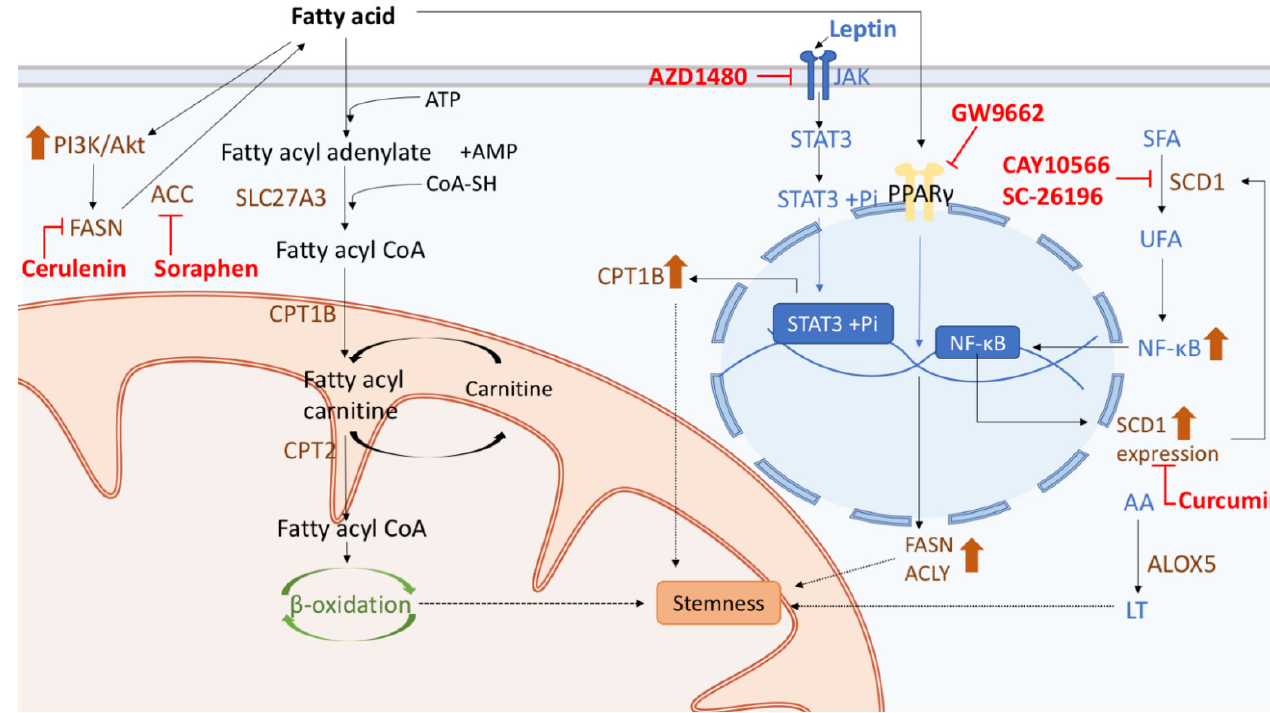
Figure 4. The regulation of fatty acid metabolism in CSCs. Lipid metabolism plays an important role in regulating the stemness properties of CSCs. In the pathway of fatty acid metabolism, acyl-CoA synthetase very-long-chain 3 (ACSVL3/SLC27A3) promotes the conversion of fatty acyl adenylate to fatty acyl CoA, which subsequently leads to β -oxidation of fatty acids and confers the stemness properties to CSCs. The generation of fatty acyl carnitine is supported by carnitine palmitoyltransferase 1B (CPT1B), which is upregulated by leptin-induced JAK/STAT3 signaling. JAK/STAT3 signaling can be repressed by AZD1480, a pan-JAK small molecule inhibitor, which may also affect the generation of CPT1B. Lipid desaturation has also been suggested to enhance CSCs maintenance, which is critically mediated by an increase of the stearoyl-CoA desaturase 1 (SCD1) activity. The enhanced expression of SCD1 leads to the transformation of saturated fatty acids (SFAs) to monounsaturated fatty acids (MUFAs), which subsequently promotes the activity of nuclear factor kappa B (NF κ B). There is a feedforward loop that unsaturated fatty acids increase SCD1 via NF κ B. The addition of curcumin blocks the expression of SCD1, which at last exerts the effect similar to CAY10566 and SC-26196 that influences the conversion of SFAs to MUFAs. Lipid metabolism enzymes such as arachidonic acid 5-lipoxygenase (ALOX5) also support the maintenance of stemness of CSCs by increasing the generation of leukotrienes (LT) from arachidonic acid (AA). Anticancer therapies targeting fatty acid metabolism may inhibit enzymes to modulate the stemness property of CSCs. The abovementioned pathways including fatty acid synthesis can be inhibited by cerulenin, soraphen and by blocking PPAR γ signaling with GW9662, respectively.